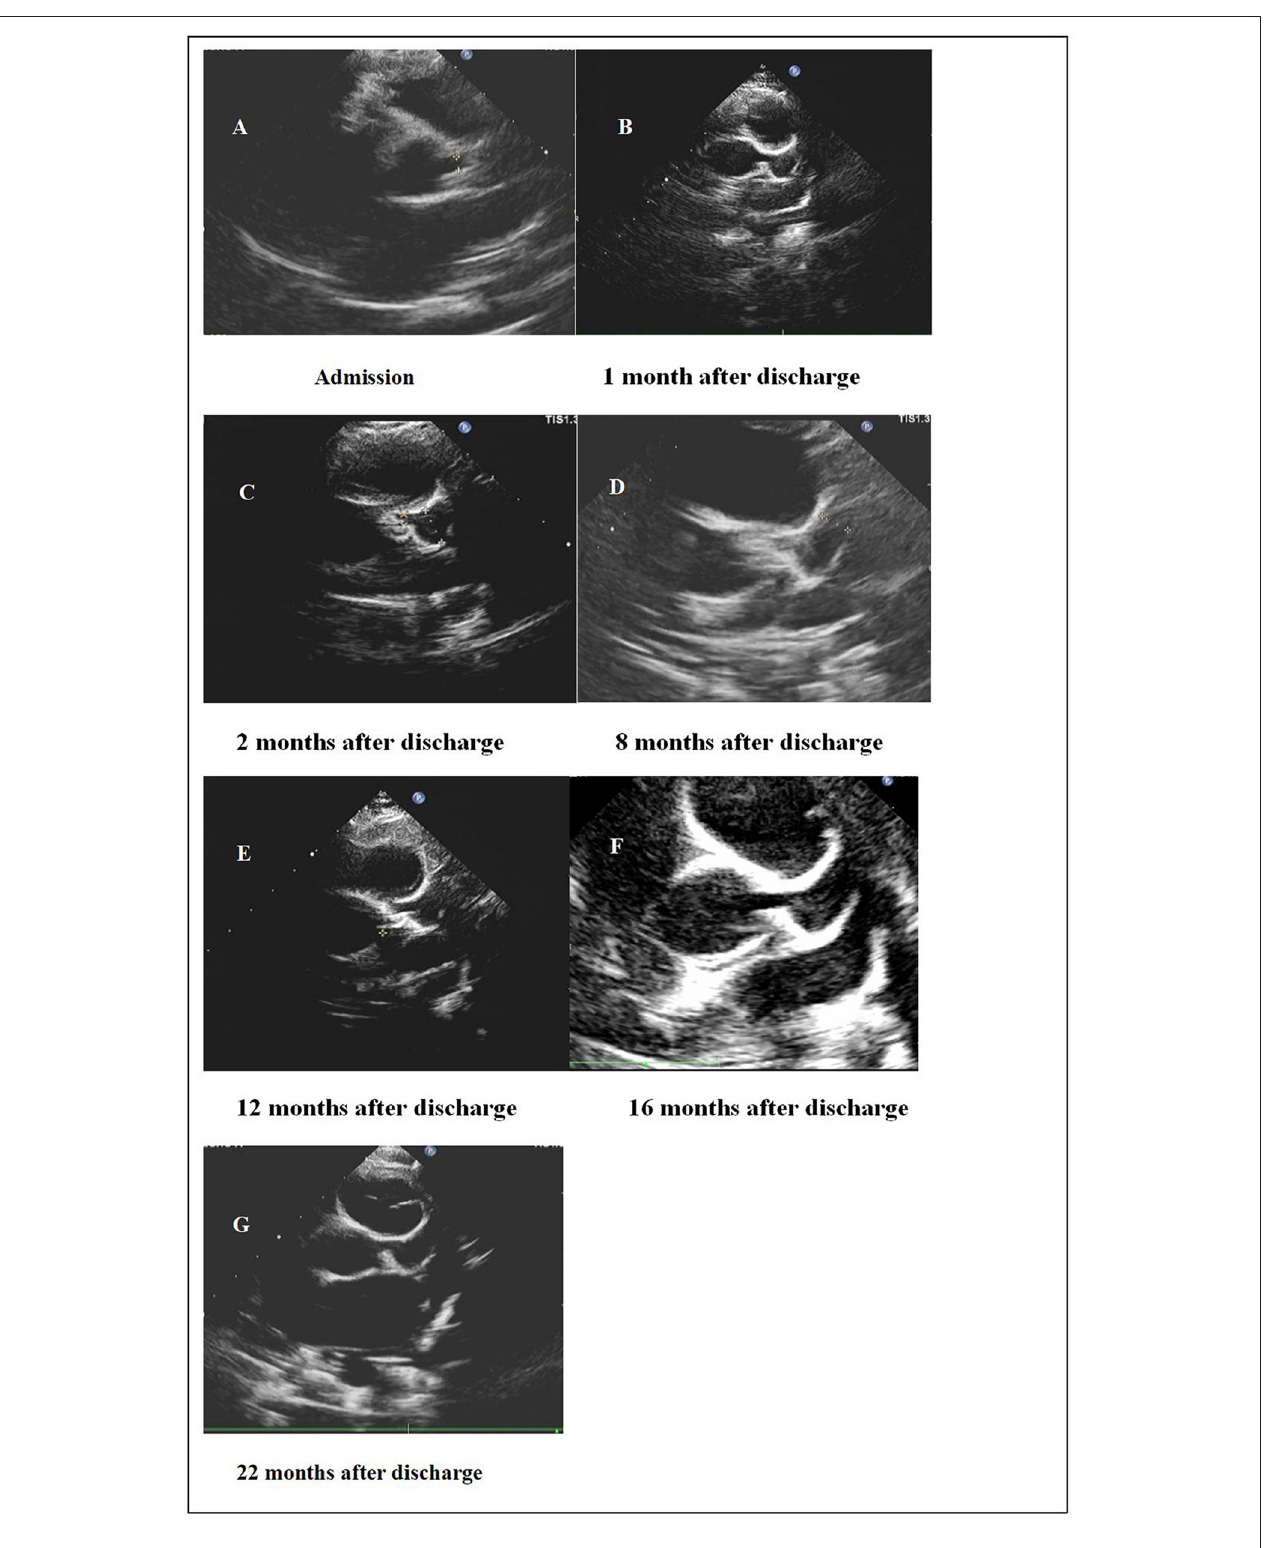
FIGURE 1 | Dilation of the left coronary artery showed by cardiac color Doppler ultrasound.